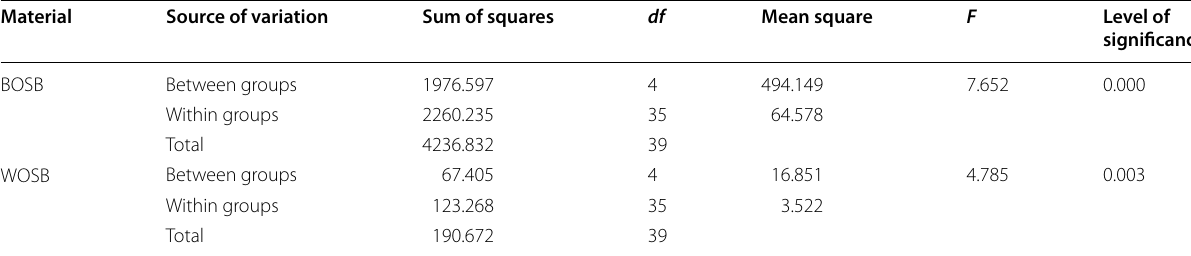
Table 2 ANOVA results of tension moment of joints Material